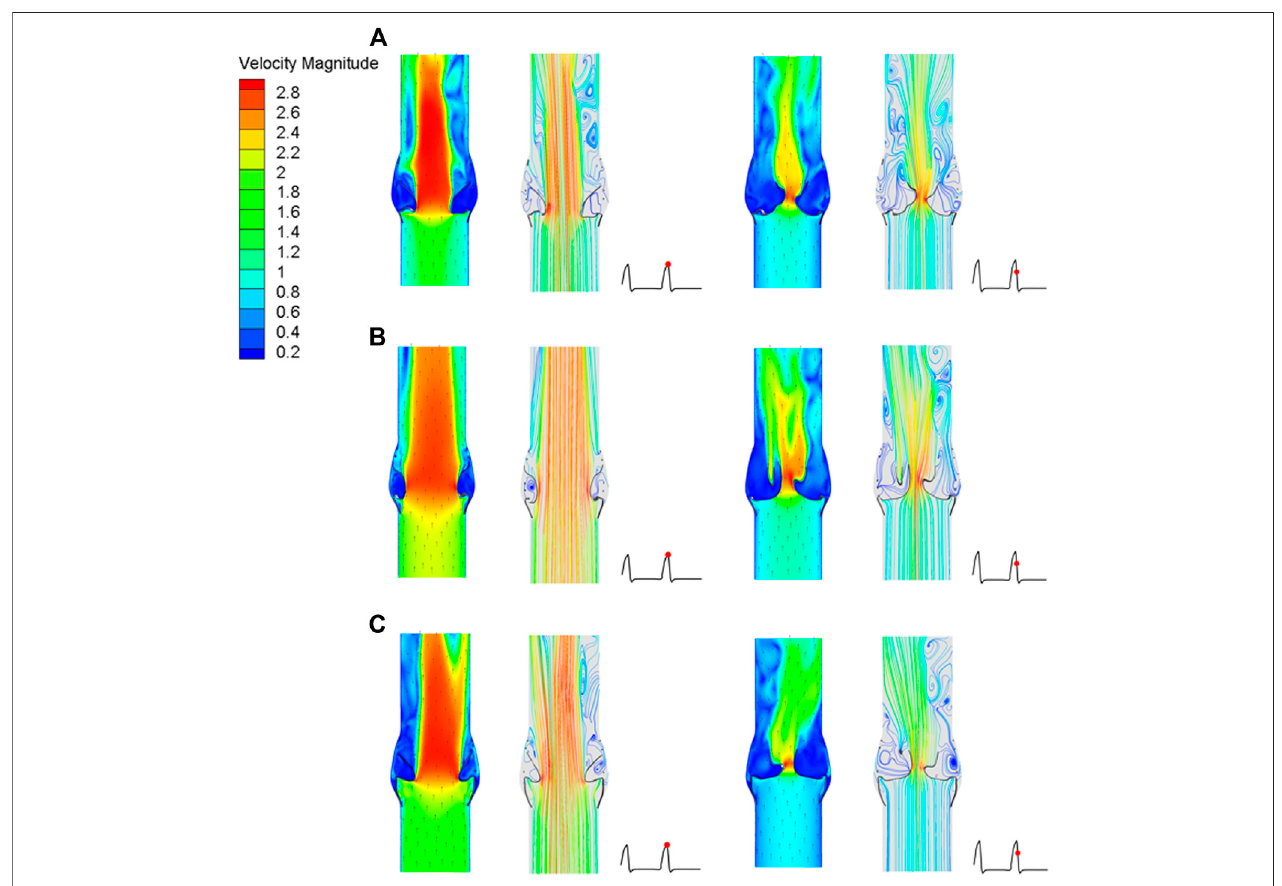
FIGURE 12 | Cross-sectional fl ow velocity distribution in two fl ow stages, (A) valve stent model A, (B) valve stent model B, (C) valve stent model C.